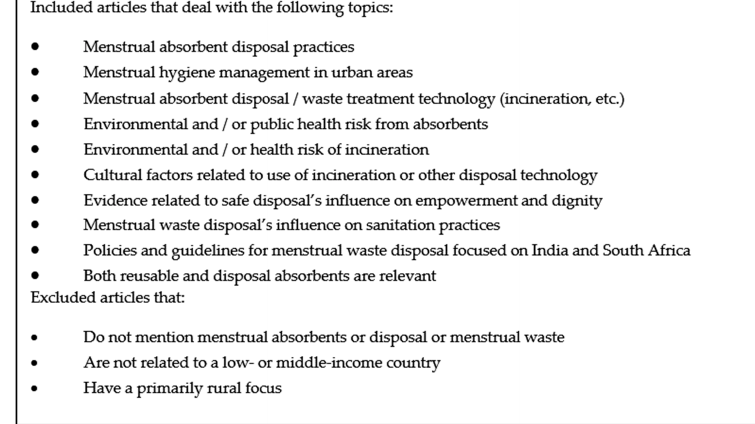
Figure 1. Inclusion/Exclusion Criteria for Literature Review.